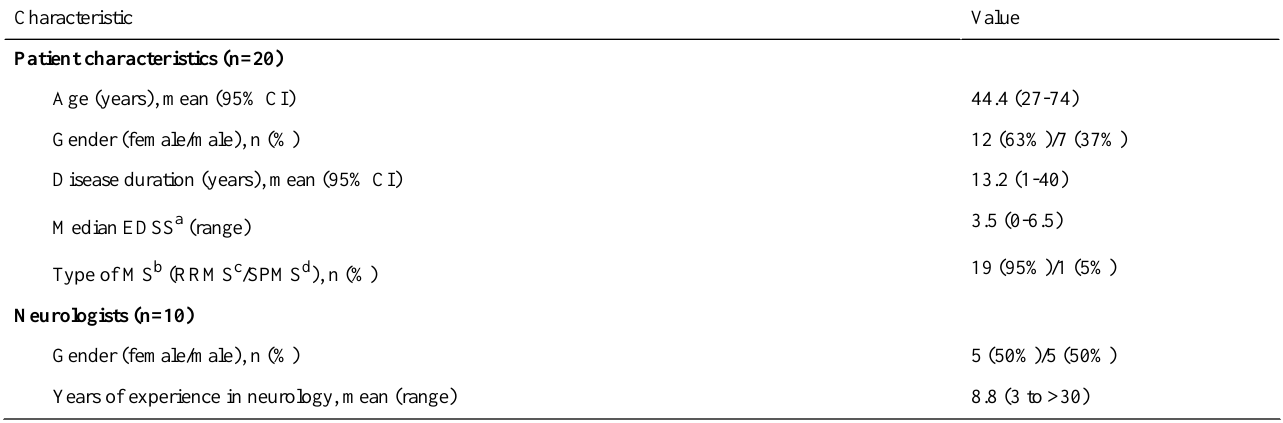
Table 1. Characteristics of the patients and neurologists who participated in the study.